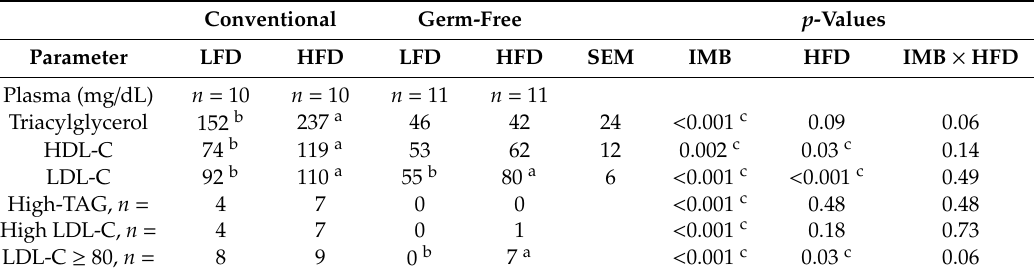
Table 5. E ff ect of the low- and high-fat diets on plasma lipid concentrations in conventional and germ-free male Tac:SW mice.